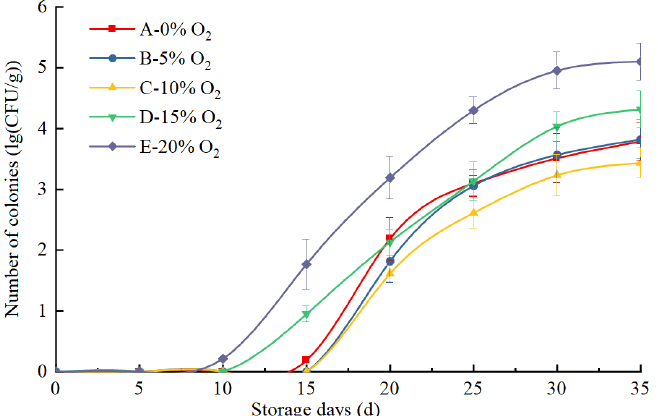
Figure 3. Changes in the total number of colonies in egg under different oxygen (O 2 ) concentrations during storage.